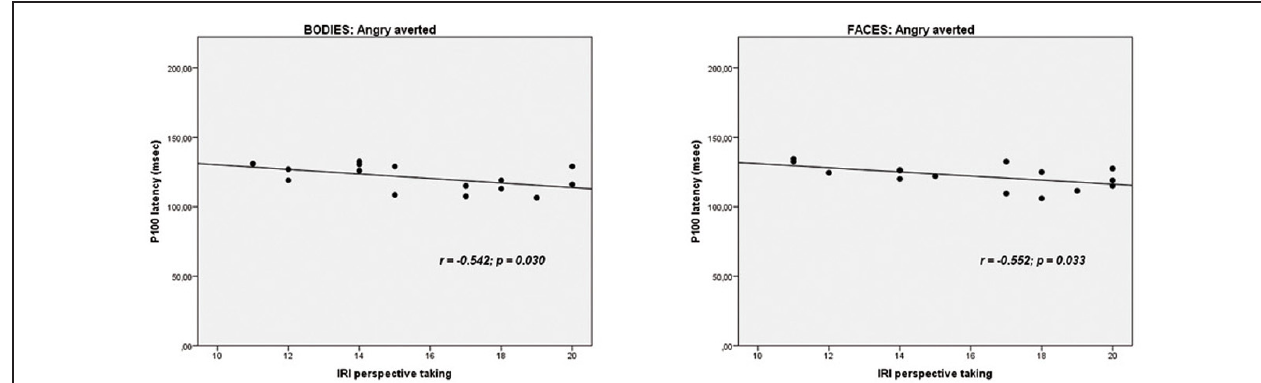
FIGURE 7 | Scatterplots depicting the correlations between trait empathy scores (BEES, Balanced Emotional Empathy Scale; IRI, Interpersonal Reactivity Index) and behavioral data and ERPs to angry emotional expressions (bodies and faces).